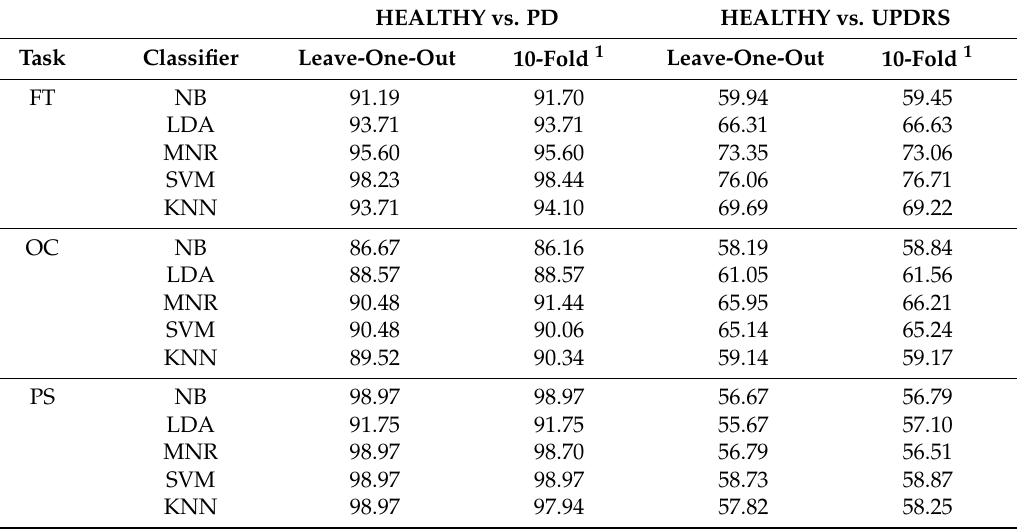
Table 6. Accuracies of classifiers for cross validation method and classification